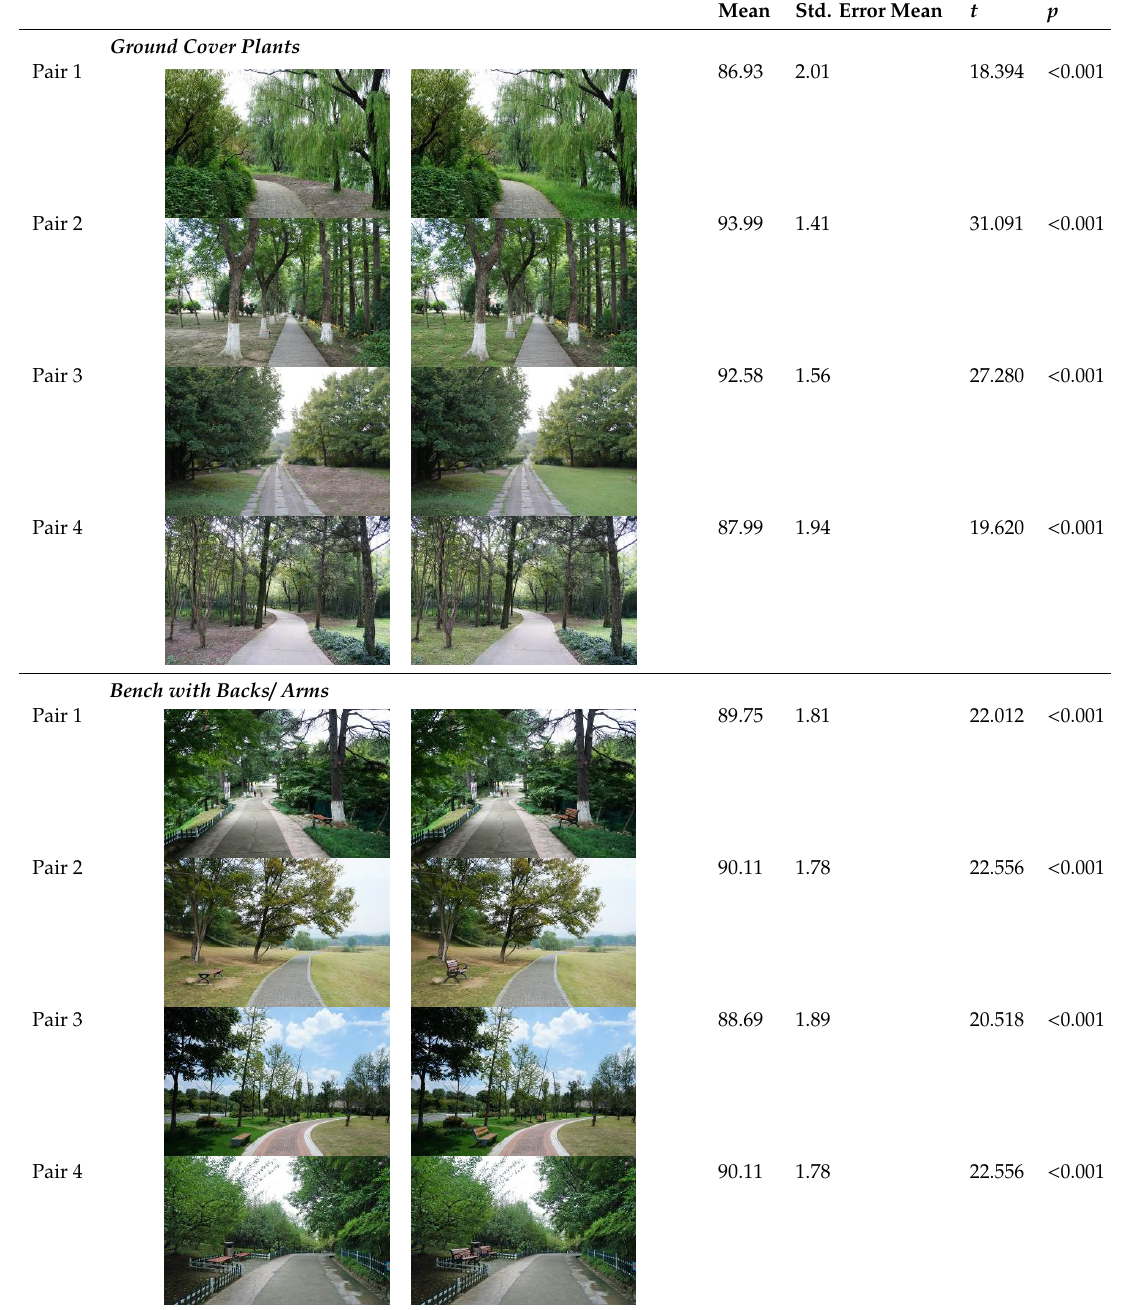
Mean Std. Error Mean t p